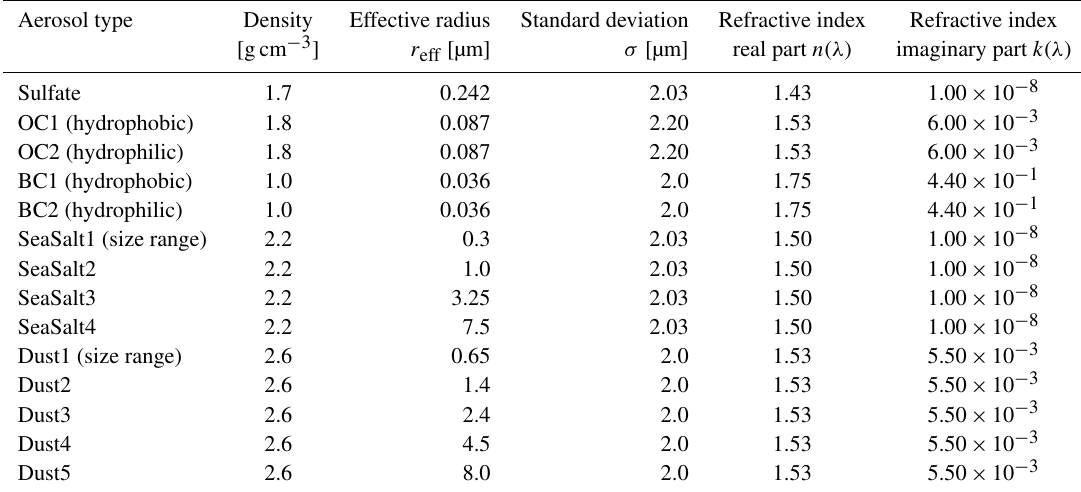
Table 1. Goddard Chemistry Aerosol Radiation and Transport (GOCART) size distribution parameters and refractive indices at 550nm for dry aerosols.